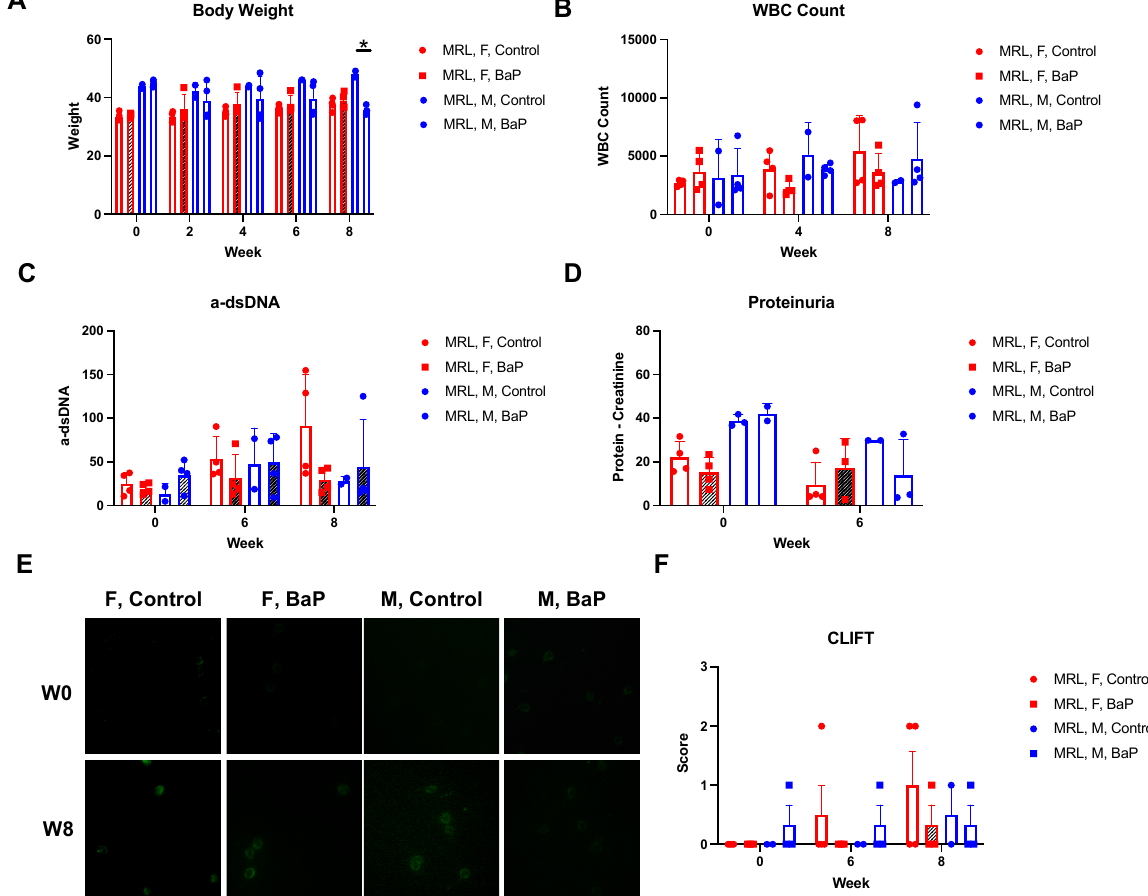
Figure 1. BaP exposure reduced the body weight of male MRL mice. Body weight ( A ), white blood cell count ( B ), a-dsDNA titer ( C ), proteinuria ( D ), and CLIFT assay (( E ), immunofluorescence (10×) and ( F ), scoring) in female (F) or male (M) MRL mice at the given time-point post-BaP treatment. Control, vehicle-treated. BaP, BaP-treated. W0, week 0. W8, week 8. *, p < 0.05.